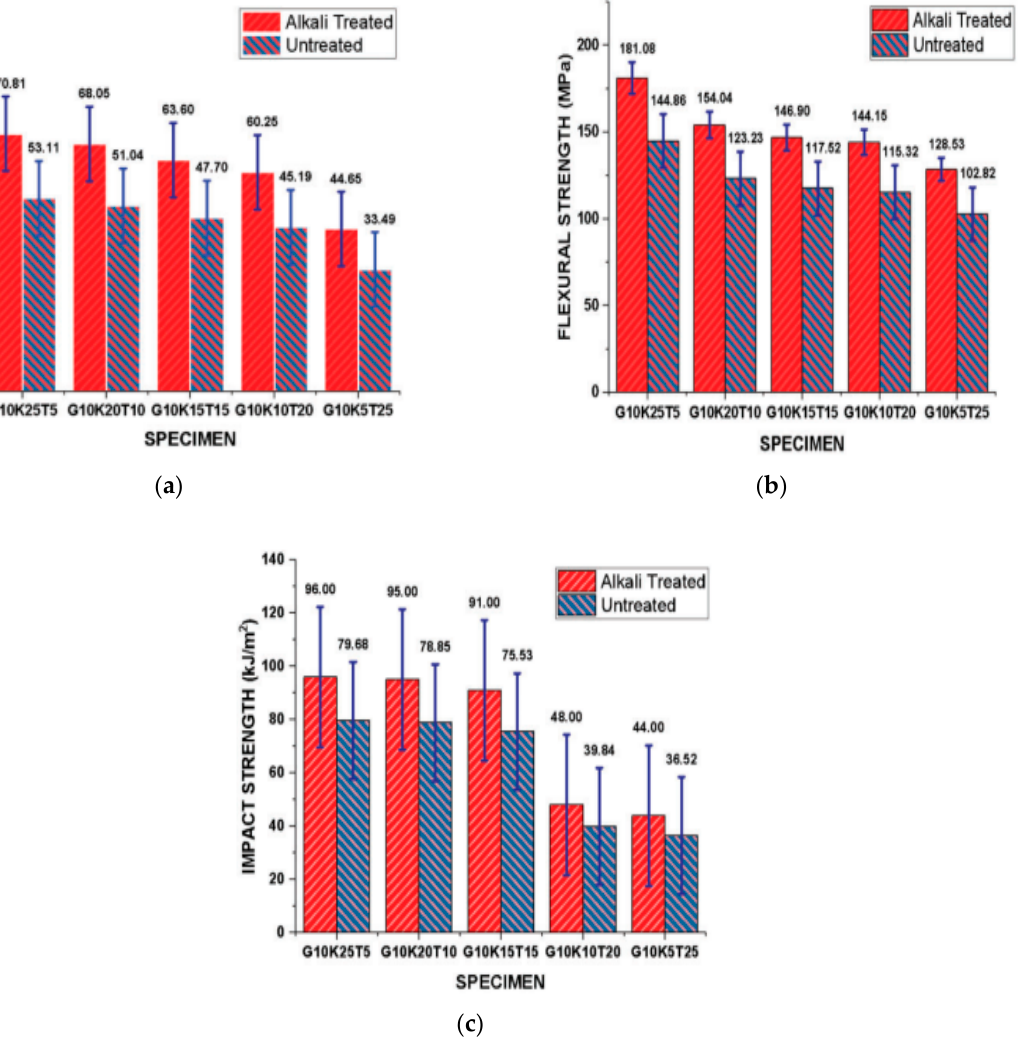
Figure 4. Mechanical properties: ( a ) Tensile strength, ( b ) flexural strength, and ( c ) impact strength of epoxy-based hybrid composites [66] (Reprinted/adapted with permission from Elsevier Ref. 5457191256269 copyright 2019).